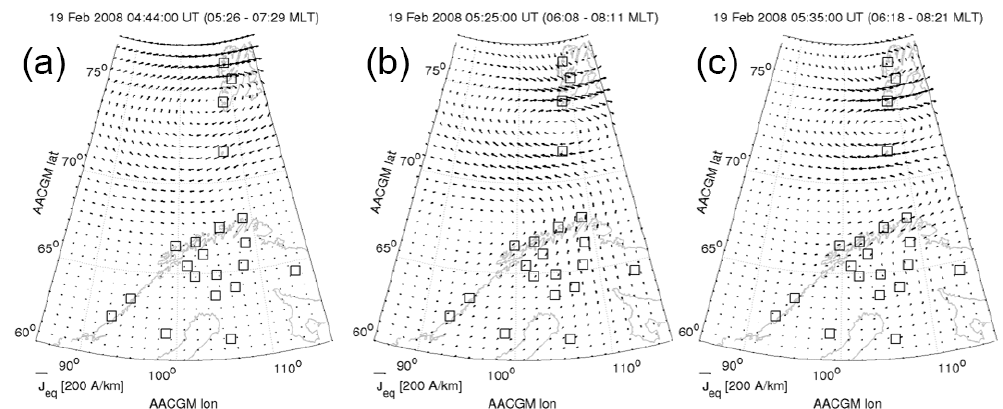
Figure 8. Examples of 2-D equivalent current plots derived from IMAGE magnetometer data recorded on 19 February 2008.